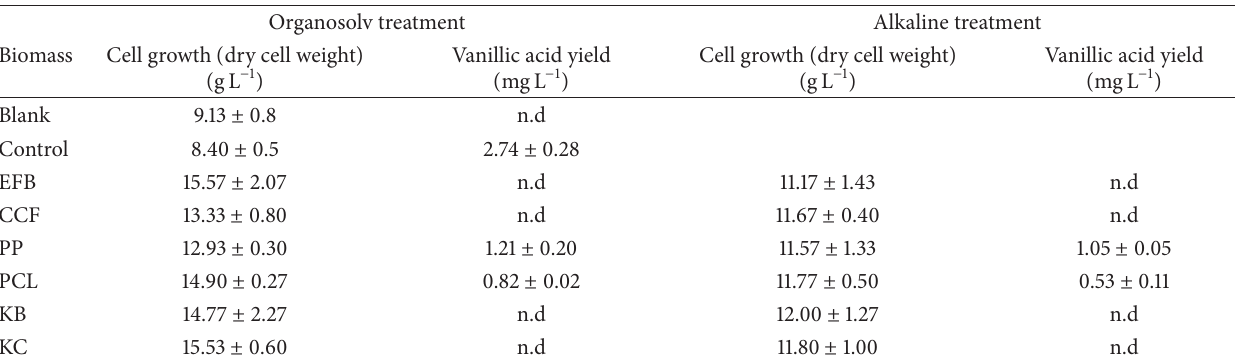
Table 5: Cell growth ( based on dry cell weight ) and vanillic acid yield from fermentation Aspergillus niger I-1472 on lignin-free liquor produced from six different biomasses through alkaline and organosolv treatment at 120 ∘ C for an hour (𝑛 = 3 ; 𝑃 < 0.05) .